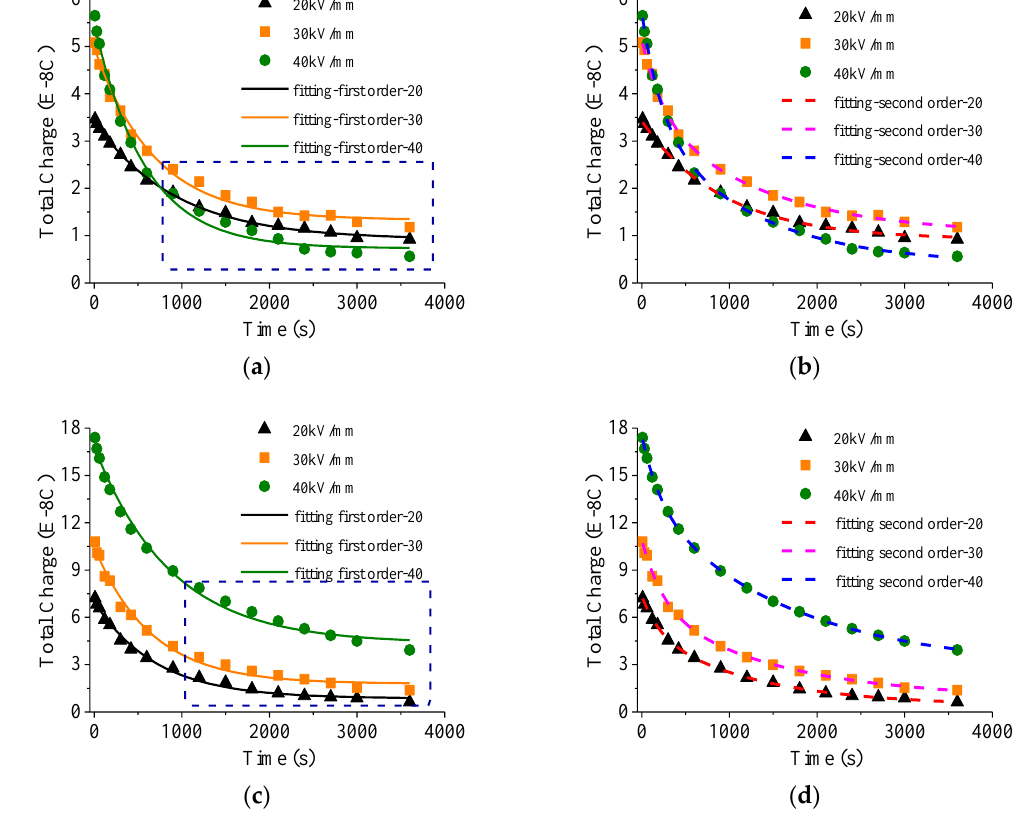
Figure 7. Common and improved method for fitting analysis of charge detrapping for oil impregnated insulation paper with new oil and aged oil being applied DC electrical field 20 kV/mm, 30 kV/mm, and 40 kV/mm for 1 h. ( a ) common method: sample with new oil; ( b ) improved method: sample with new oil; ( c ) common method: sample with aged oil; ( d ) improved method: sample with aged oil.